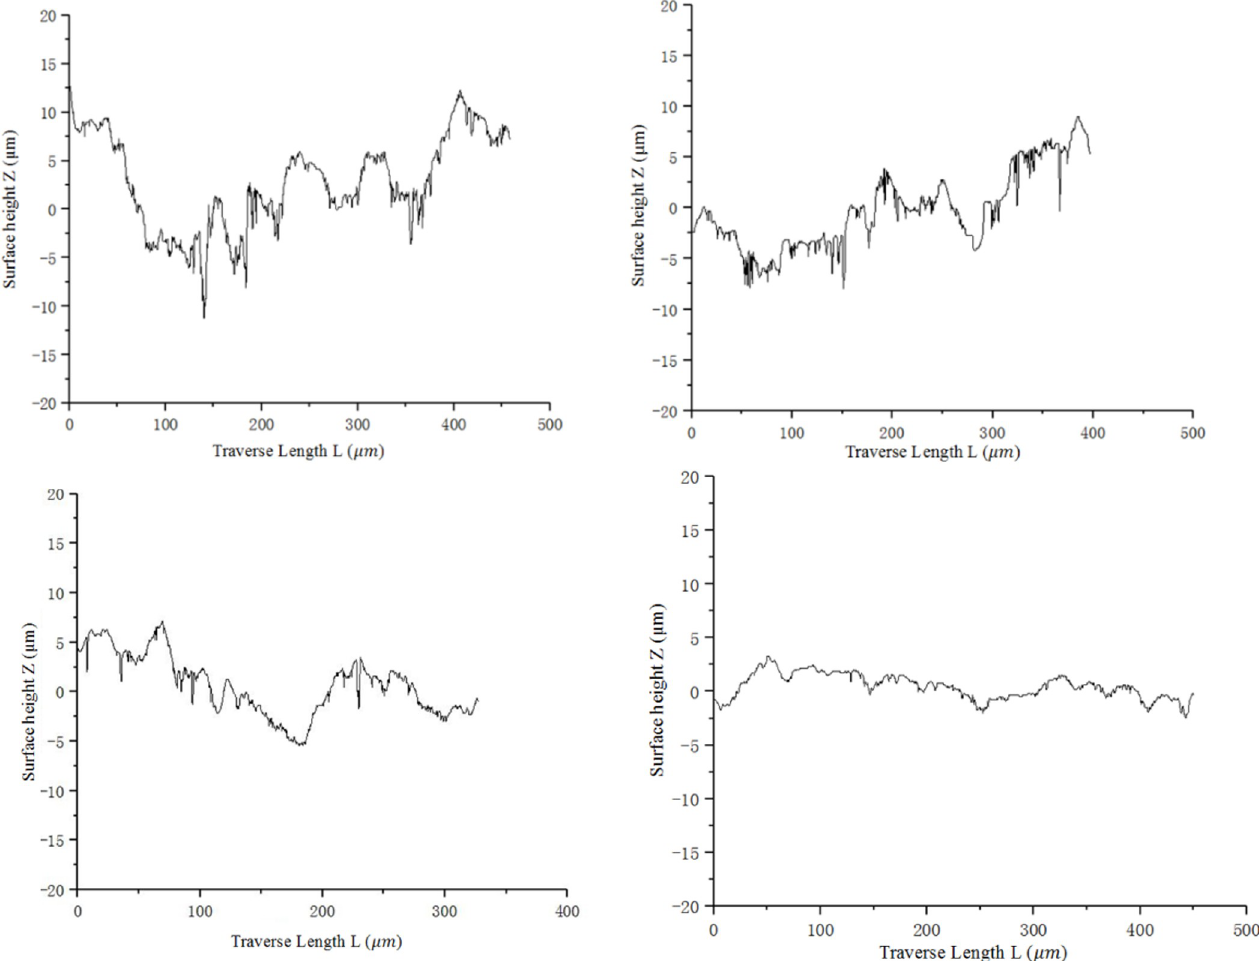
Fig 15. Surface morphology of specimens after grinding.